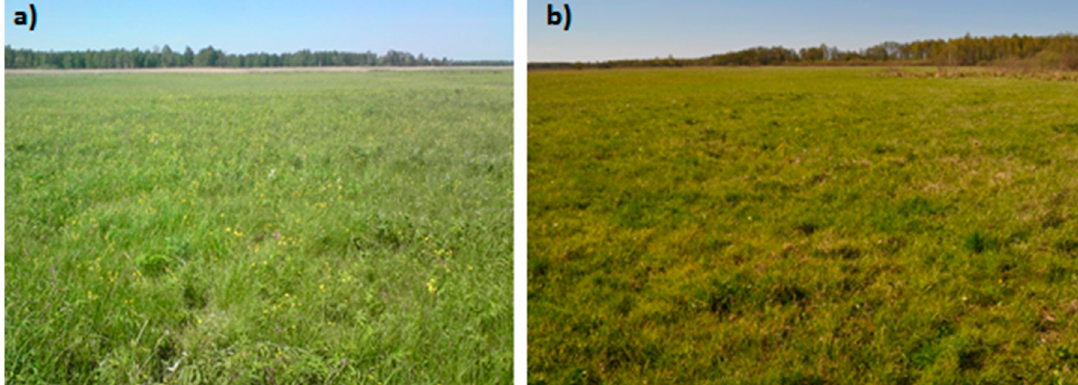
Figure 2 . Meadows under extensive agricultural use (( a ) in Summer; ( b ) in Autumn).